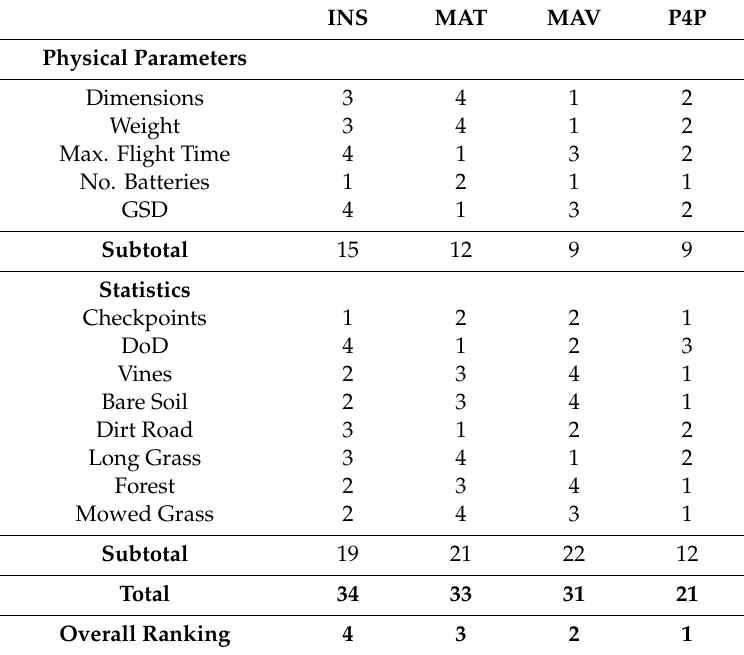
Table 7. Overall summary of UAS